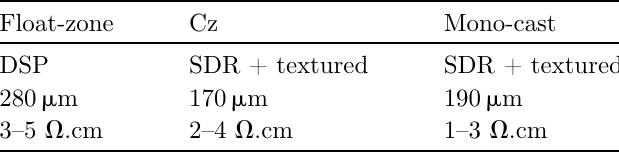
Table 1. Characteristics of p -type wafers used for lifetime samples. SDR stands for saw damage removal, and the texturation bath is composed of KOH and